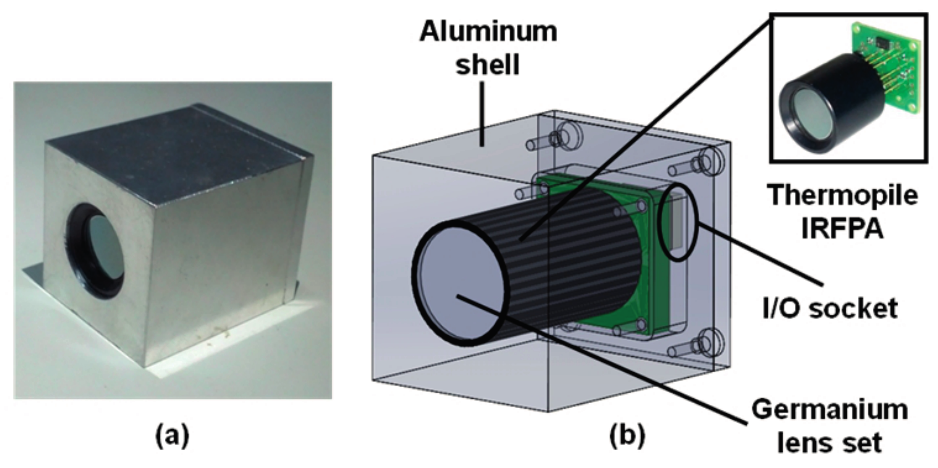
Figure 3. The design of Infrared Thermal Module (TIM). ( a ) Integrated TIM working prototype; ( b ) The interior structure of